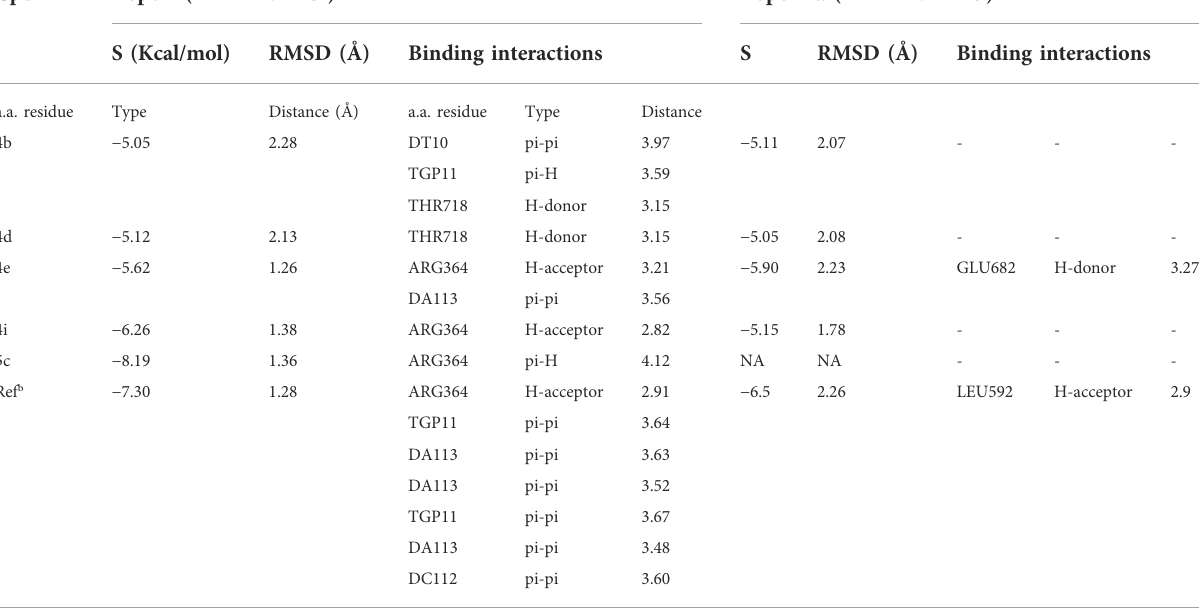
TABLE 3 Docking Score and Binding Interactions of 4b, 4d, 4e, 4i and 5c within active sites of Topo I and Topo II α proteins (PDB ID: 1T8I and 4FM9; respectively). Cpd Topo I (PDB ID: 1T8I) Topo II α (PDB ID: